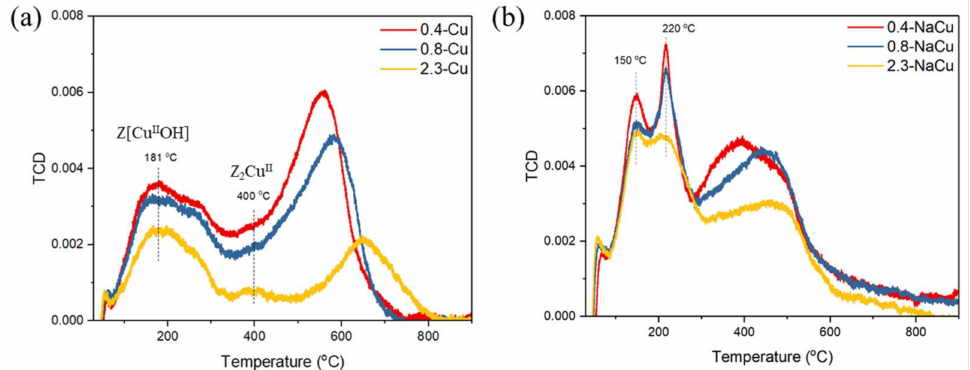
Figure 5. H 2 -TPR profiles of Cu/SSZ-13 with different crystal sizes ( a ) before and ( b ) after Na